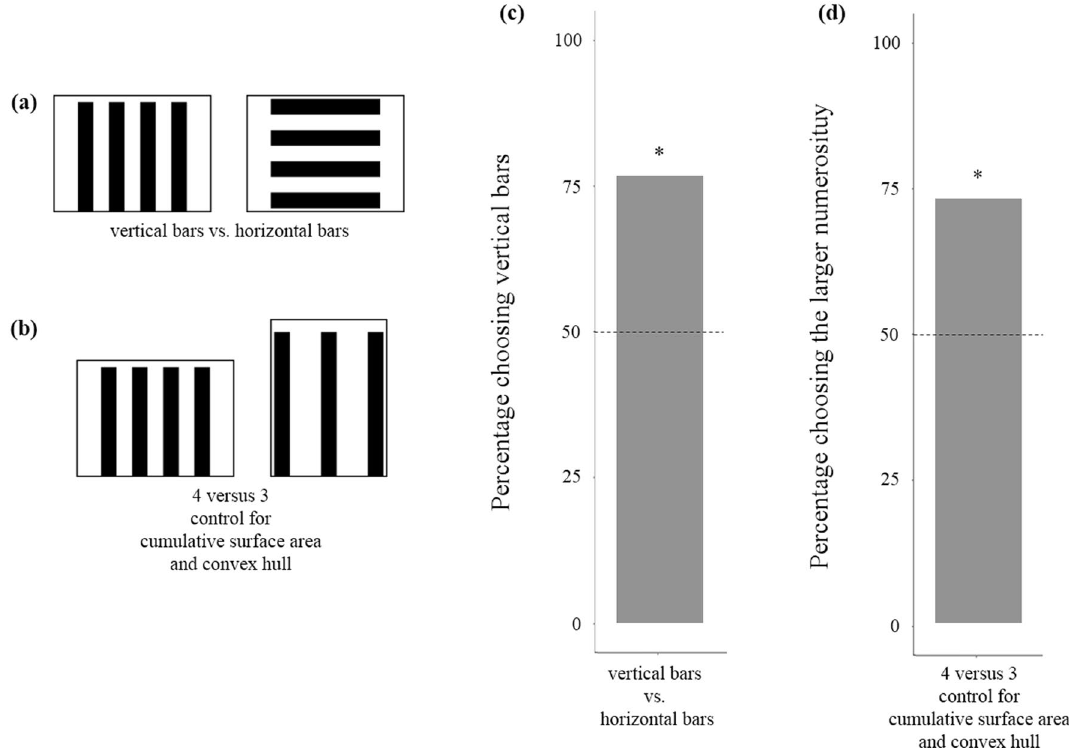
Figure 6. ( a , b ) Stimuli used in Experiment 4a and 4b respectively. ( c ) In Experiment 4a, snails showed a significant preference for the stimulus with vertical bars ( P = 0.004). ( d ) In Experiment 4b, snails showed a significant preference for the stimulus with larger numerosity ( P = 0.011). Dotted line represents the expected preference by chance, and asterisks indicate significant deviations from the chance level ( P <